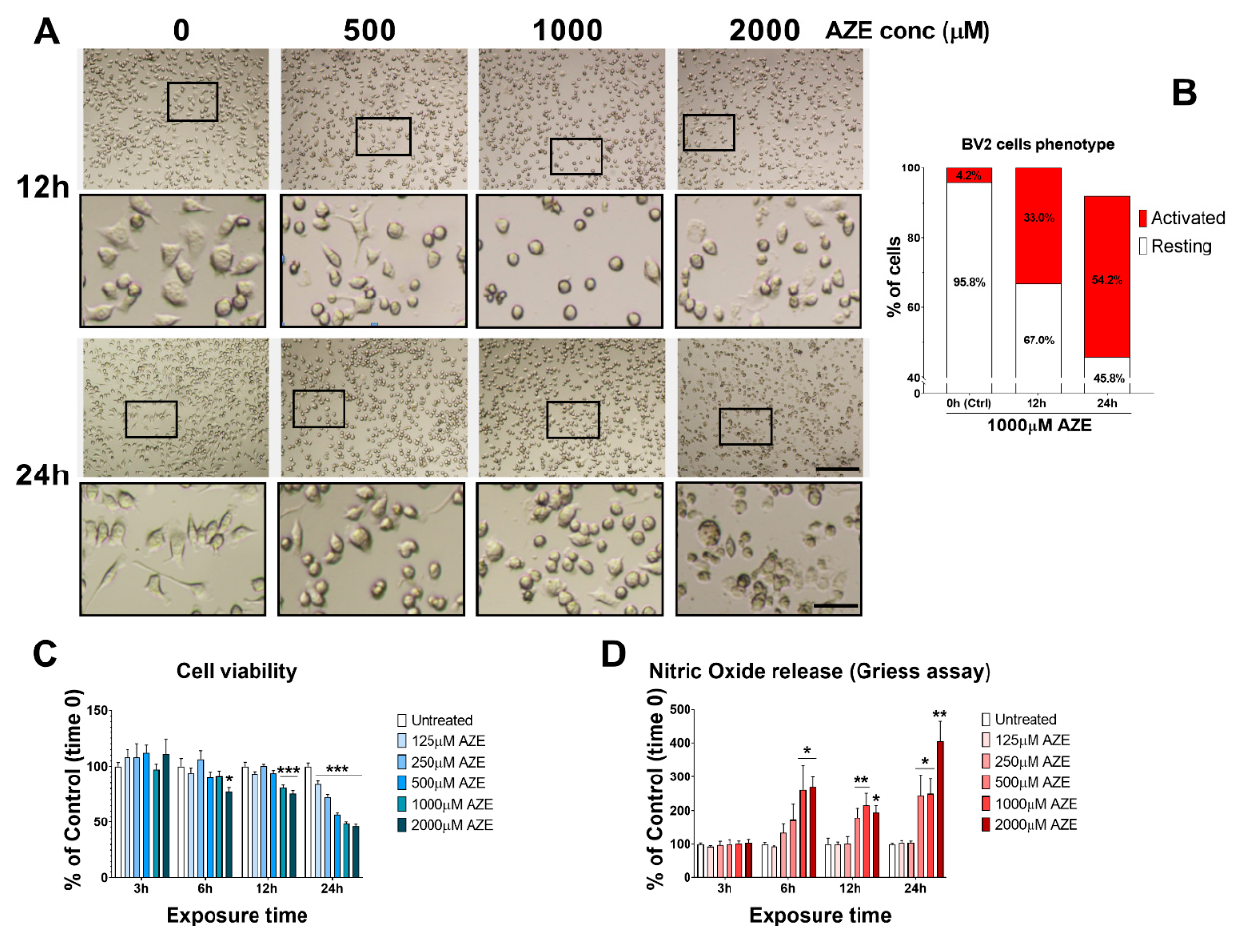
Figure 1. Dose–response effects of AZE exposure on BV2 microglial cell viability and inflammatory response. ( A ) Morphological changes seen in microglial BV2 cells following various AZE concentrations (0, 500, 1000, 2000 µ M) after 12 and 24 h. Representative photomicrographs were taken using a bright field microscope with the embossing filter settings. Magnification = 10 × , scale bar = 200 µ m. Black squares indicate the ROI shown at higher magnification in insets. Insets below each photomicrograph show high magnification details of cellular morphology. Magnification = 40 × , scale bar = 50 µ m. ( B ) Phenotypic presentation of BV2 cells (Activated vs. Resting). % of cells of each phenotype was determined by counting the # of cells that showed signs of activation (flat and swollen) vs. the total number of cells per region of interest (ROI) and expressed as a percentage (n = 5 ROI × 3 batches of cells). ( C ) Cell viability, measured by MTT assay. Cells were treated with varying AZE concentrations (0, 125, 250, 500, 1000, 2000 µ M) for 3, 6, 12 or 24 h. * p < 0.05 or *** p < 0.001, as determined by ANOVA followed by Dunnett’s post hoc test. ( D ) Nitric oxide release, assessed using the Griess assay. Cells were treated as in C and NO levels were measured in culture media. Values are reported as the percentage NO release of untreated controls. Data reported as mean ± SEM. * p < 0.05, ** p < 0.01, as determined by ANOVA followed by Dunnett’s post hoc test.